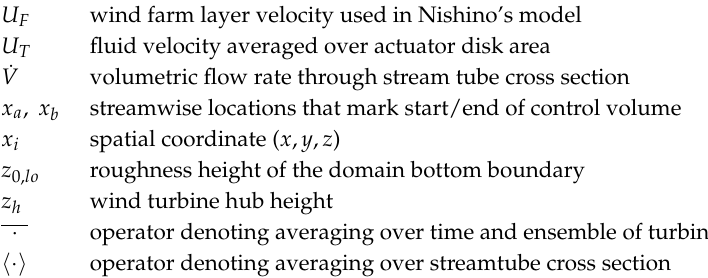
Table A1. Comparison of C T calculations using different methods. “Turbine Only CV” and “Entire Streamtube CV” are computed by summing the terms on the right hand side of Equation (10). Residuals are shown as a percentage of C T calculated directly from Equation (9), except for C (cid:48) by definition.